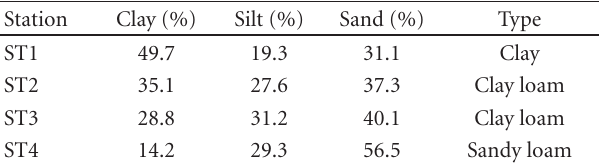
Table 4: Results of texture